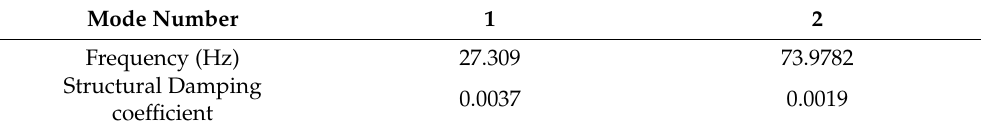
Table 4. Experimental natural frequencies and damping coefficients of the intact steel beams.